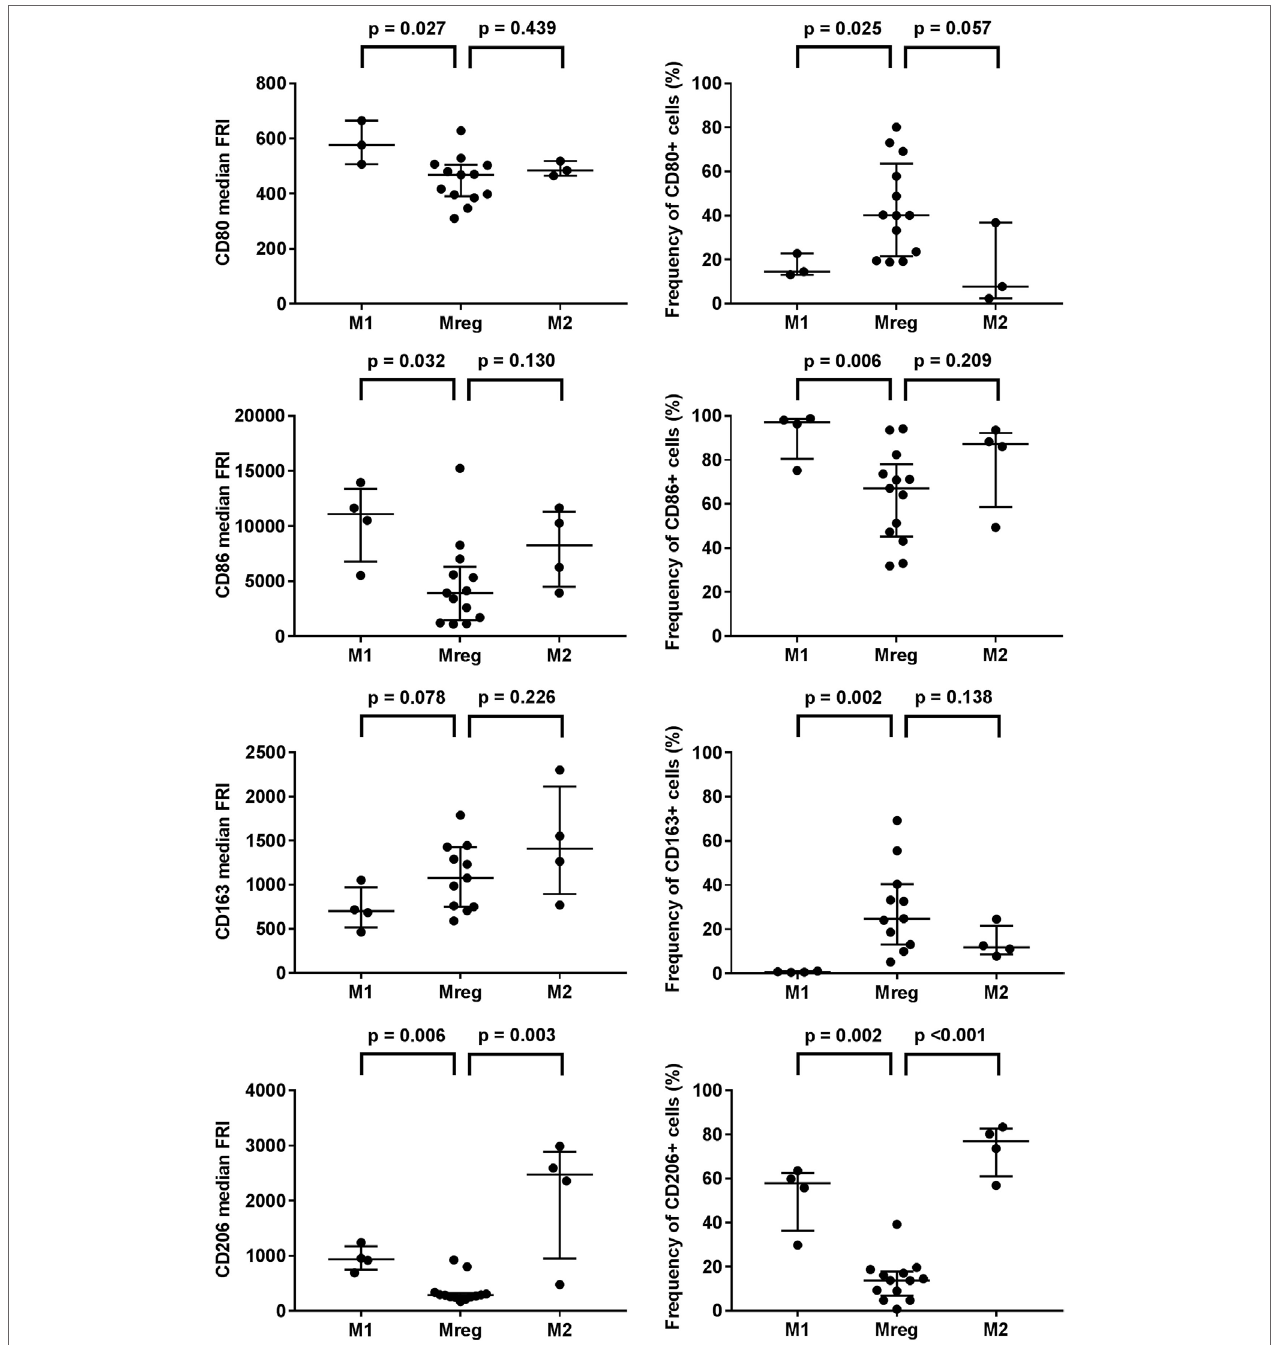
FigUre 1 | Phenotypes of M1, M2, and Mreg subtypes. The antibody staining was performed with PE-CD80, PE-Cy7-CD86, BV421-CD163, and APC-CD206 according to the manufacturers’ instructions. The median fluorescence intensities (left panel) and frequencies of positive cells (right panel) were determined with flow cytometry analysis. The significance in pairwise variation between M1 and Mreg, and M2 and Mreg was analyzed using the Mann–Whitney U test. The results are presented as median with interquartile range. The number of biological replicates varied from 3 to 13. Abbreviations: FRI, fluorescence intensity; M1, classically activated “host defense” macrophage; M2, alternatively activated “wound-healing” macrophage; Mreg, regulatory